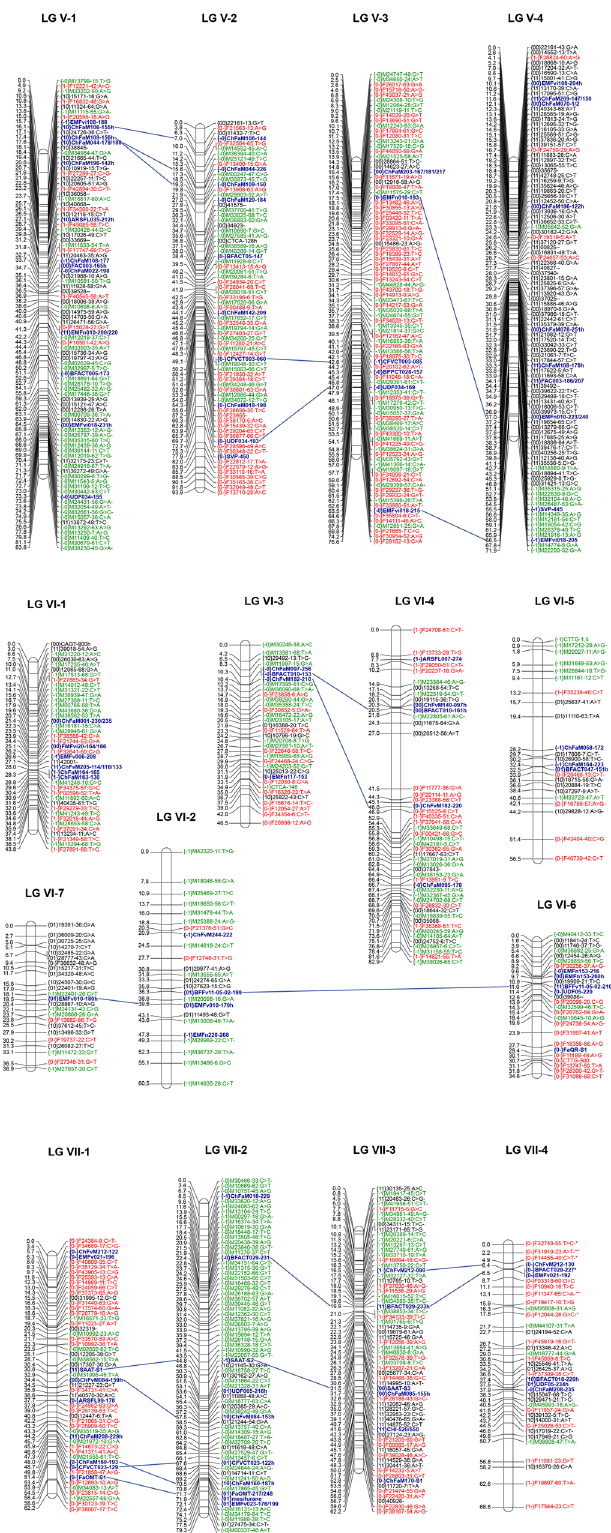
Fig 4. Integrated linkage map for strawberry using the ‘ 232 ’ × ‘ 1392 ’ population, DArTseq SNP and previously mapped SSR markers (Homoeology groups 5 to 7). Markers labeled as in Fig 3.